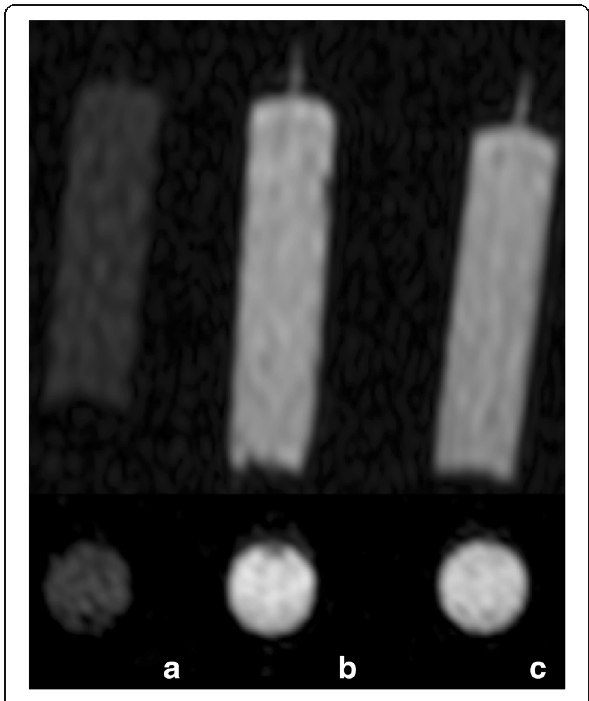
Fig. 3 MRA axial and the corresponding coronal images of three 10-mL syringe filled with: ( a ) pineapple juice; ( b ) concentrated pineapple juice plus modified potato starch; and ( c ) saline